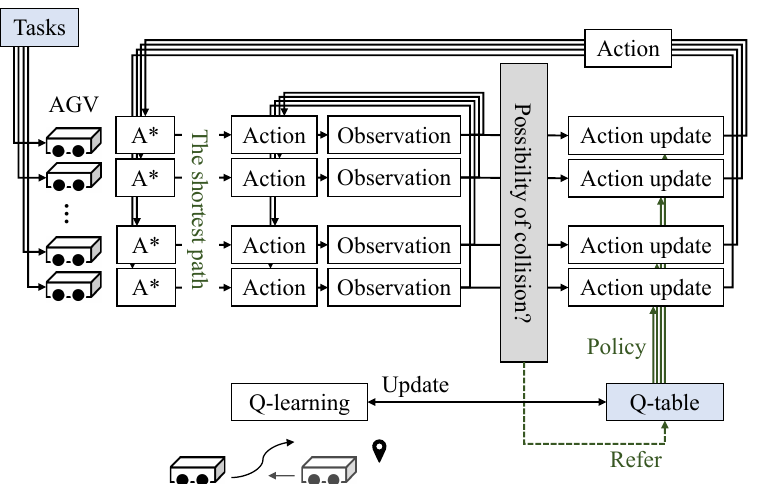
Figure 4. Framework for the proposed method. Each AGV performs A* and Q–learning indepen- dently. Collision determination is performed by a central computing system that integrates the positions of all